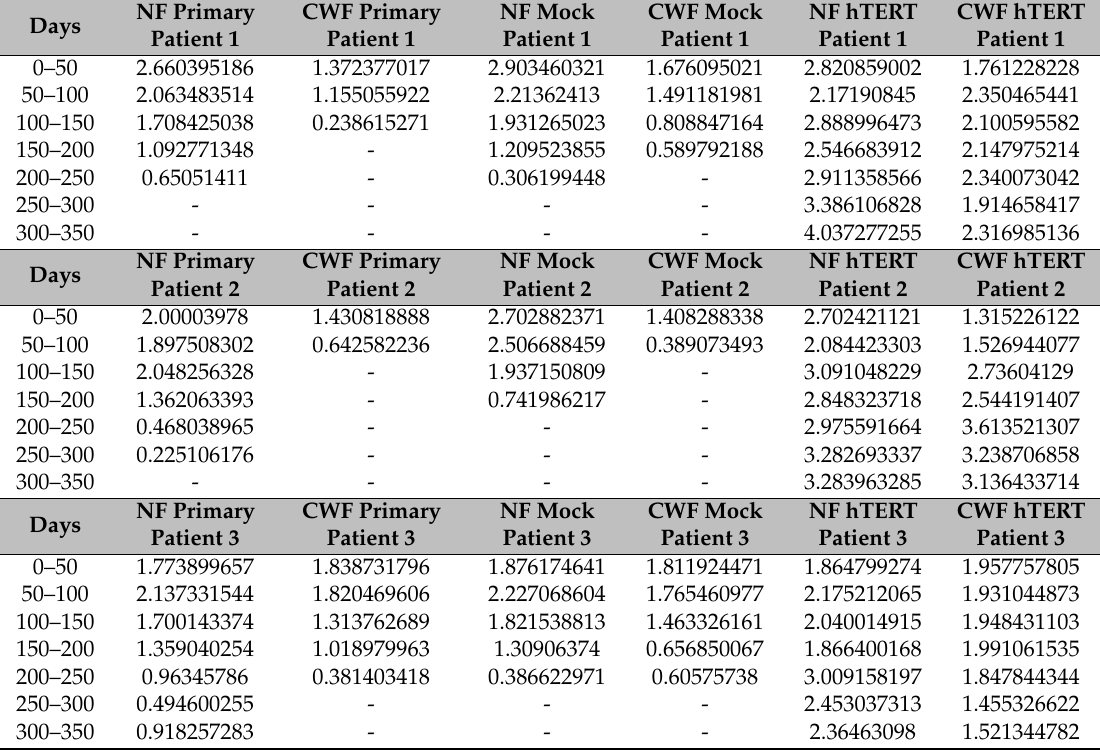
Table 1. Respective growth rates of the CWF and NF cell lines and strain.